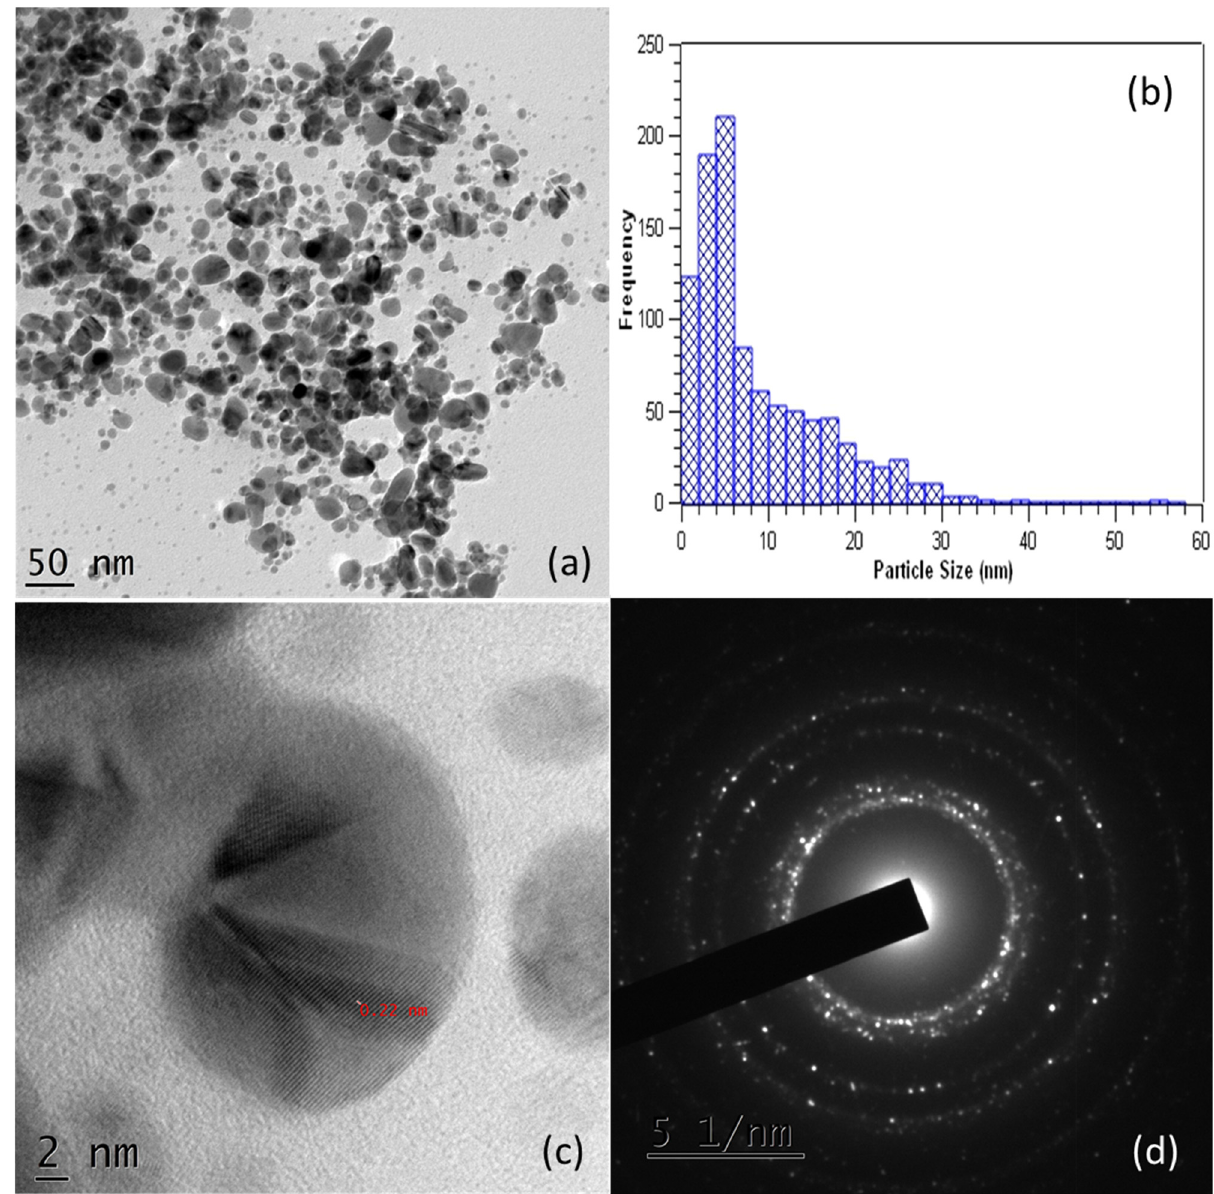
Figure 8: ( a ) TEM image, ( b ) histogram of particle sizes obtained from the TEM image, ( c ) HRTEM image, and ( d ) SAED